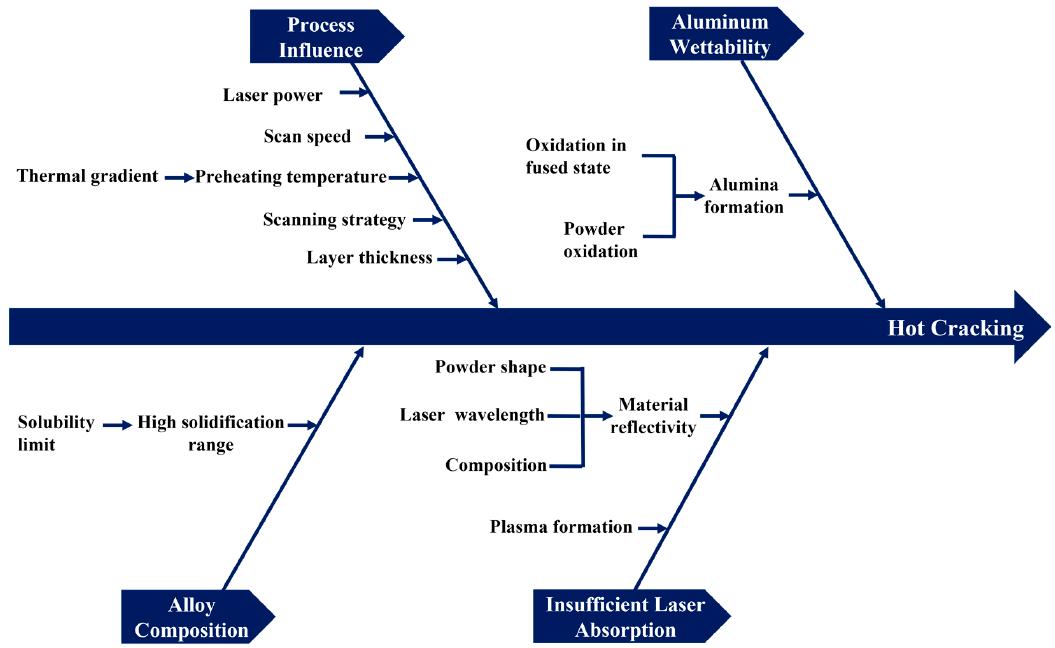
Figure 4. Different causes for the formation of hot cracking in metal AM of HS ‐ Al alloys.